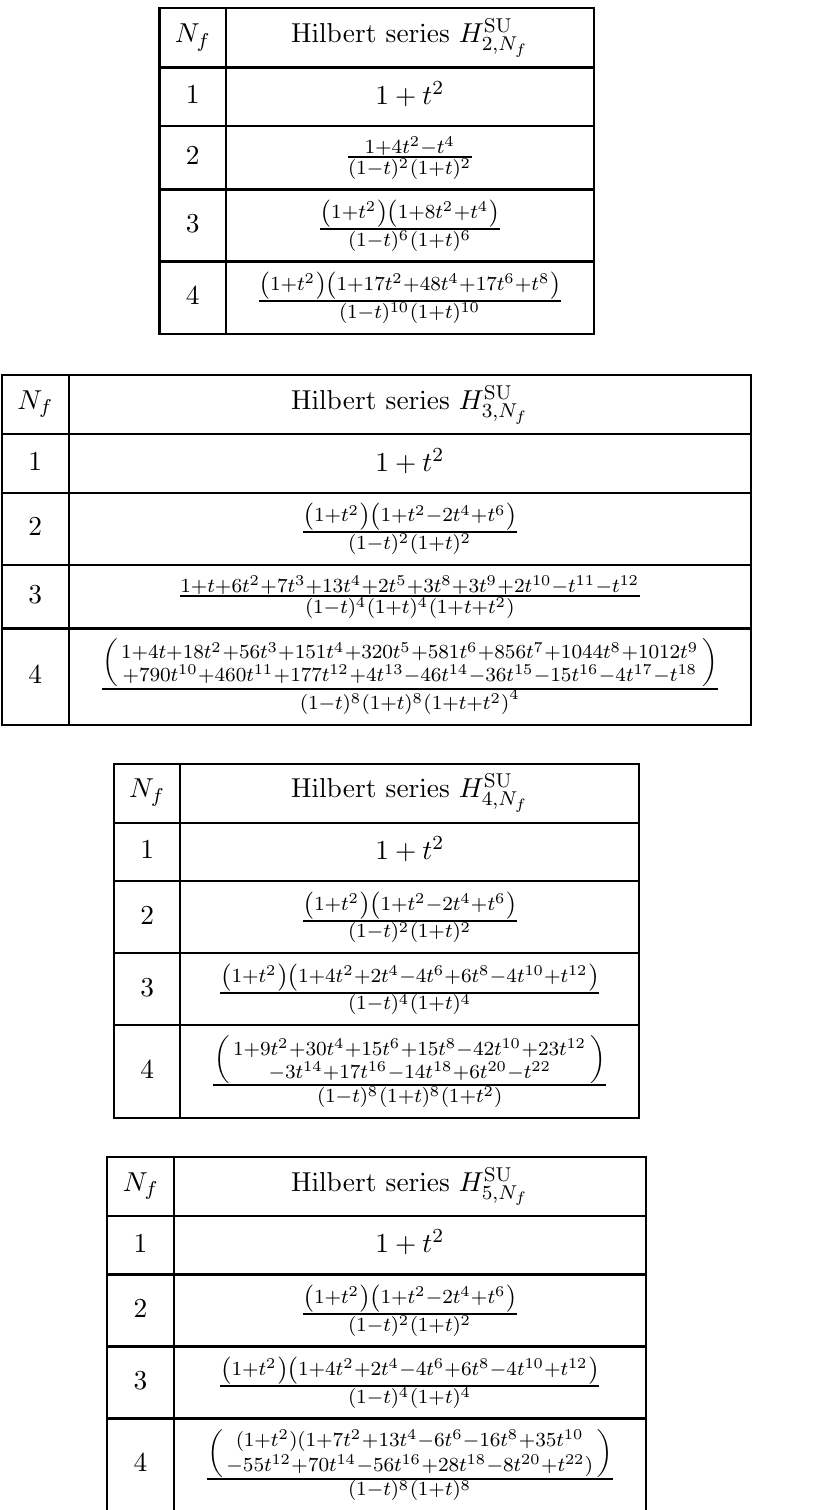
Table 4 . Hilbert series H SU computed using the hyper-K¨ahler